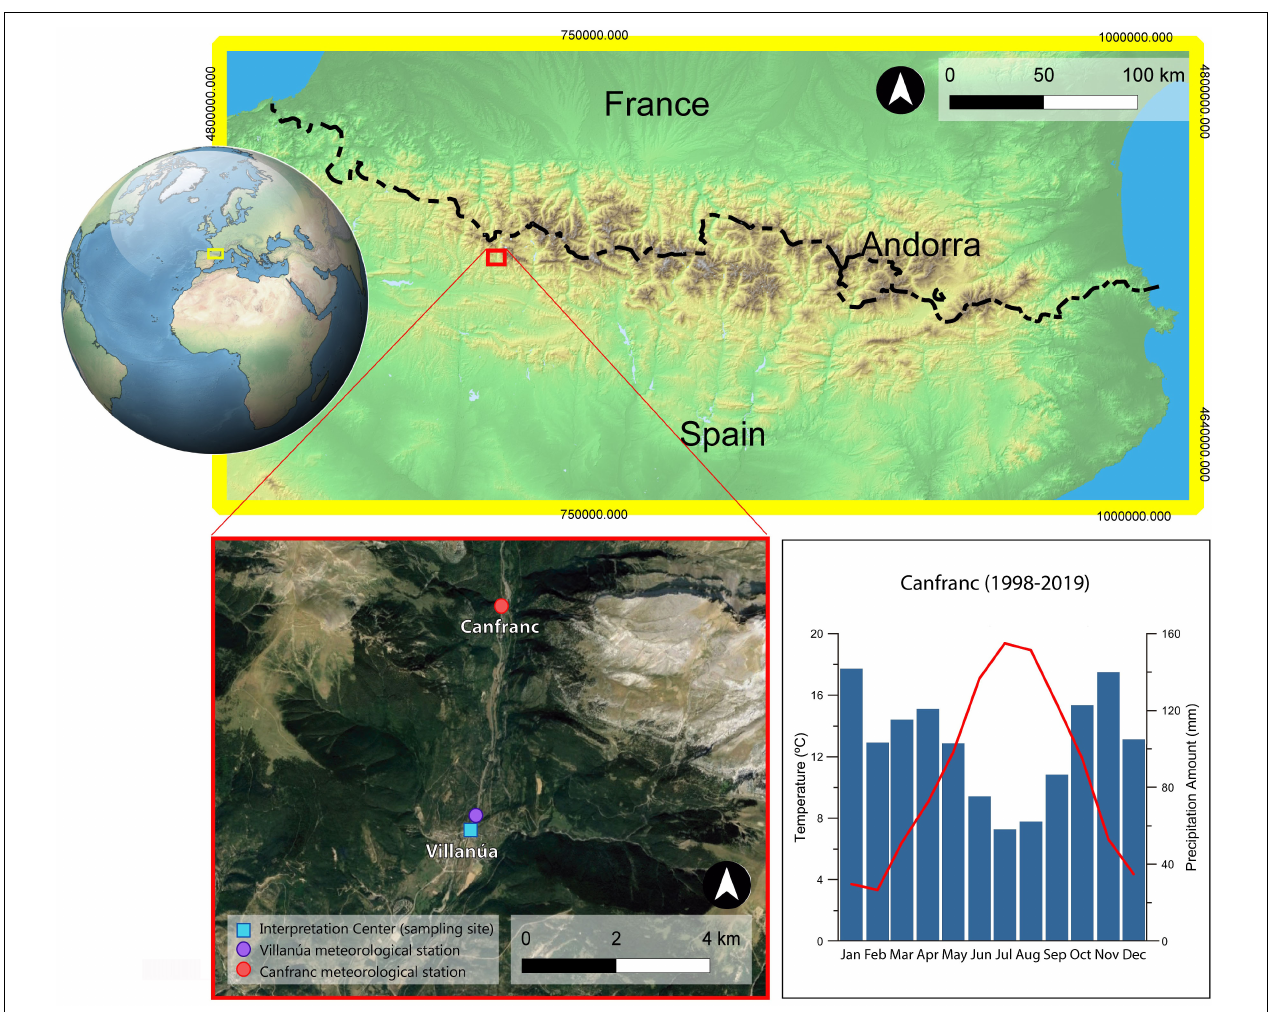
FIGURE 1 | Location of the precipitation sampling site in Villanúa and meteorological stations (DGT station in Villanúa and SAIH—Ebro station in Canfranc) in the Aragon Valley (Central South Pyrenees). Pyrenees map from ASTER GDEM (NASA v3, 2019) and aerial view of Aragon Valley from Google Earth. Ombrothermic diagram shows monthly precipitation amount averaged over 22 years (from 1998) and air temperature averaged over 18 years (from 2002) based on climatological data obtained from the meteorological station at Canfranc village. This location is 4 km to the north of the precipitation sampling site in Villanúa, having similar mean annual air temperature (10.7 ◦ C) and slightly higher precipitations (1,235